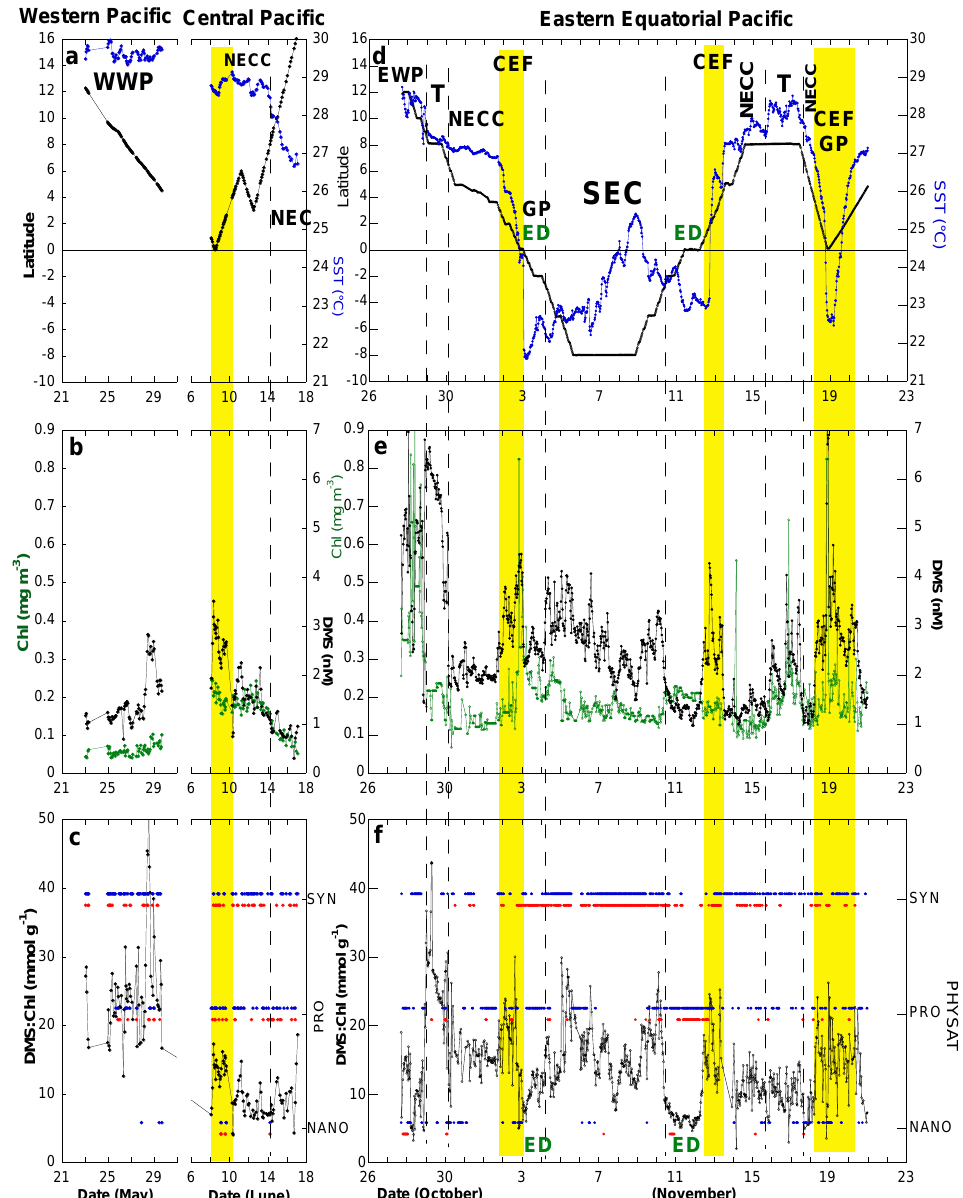
Fig. 7. Temporal variations of the following parameters in the western and central (left panels cruise CN-169) and eastern (right panels, cruise CN-148) Equatorial Pacific: (a, d) sea surface temperature (SST: ◦ C, in blue) and latitude (in black), (b, e) ocean color (Chl: mgm − 3 , in green) and sea surface dimethylsulfide concentration (DMS: nM, in black), (c, f) DMS-to-Chl ratio (DMS:Chl, mmolg − 1 , in black) and monthly (red dots) and monthly climatological (blue dots) composites of phytoplankton group dominance. The yellow vertical bands correspond to the convergent equatorial front (CEF) where DMS accumulates. WWP: western warm pool, NEC: north equatorial current, EWP: eastern warm pool, NECC: north equatorial counter current, T: transition zone between EWP and NECC, GP: Galapagos plume, ED: equatorial divergence, SEC: south equatorial